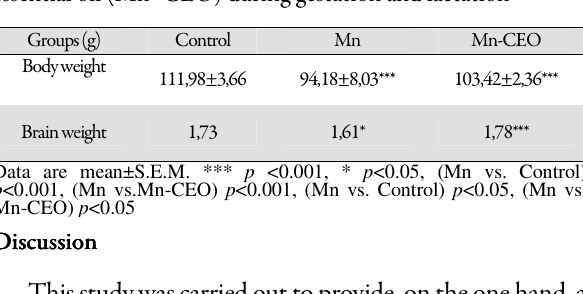
Tab. 1. Body weight (g) and brain weight (g) of control (c) and Manganese ‑ exposed rats and Mn ‑ treated rats by clove